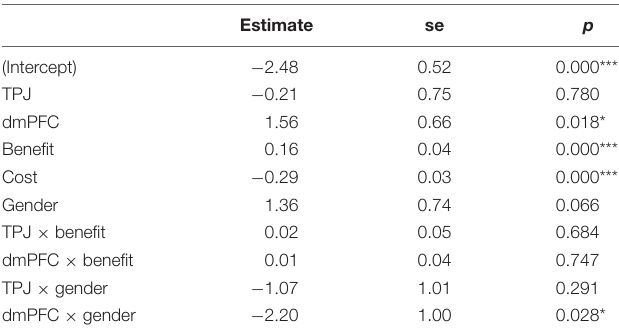
TABLE 1 | Logistic regression coefficients indicating the effects of tDCS treatment, gender, benefit, and cost of altruism on altruistic